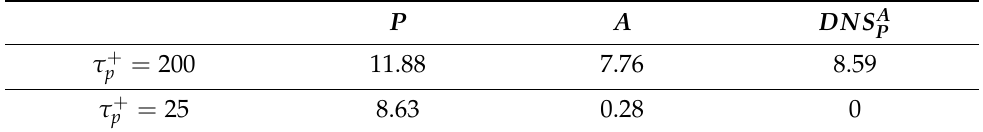
Table 3. Relative error of prediction of peak values and positions of rms + v (in percentage). Nomen- clature: P , Position; A , Amplitude; DNS A , DNS Peak Amplitude. P